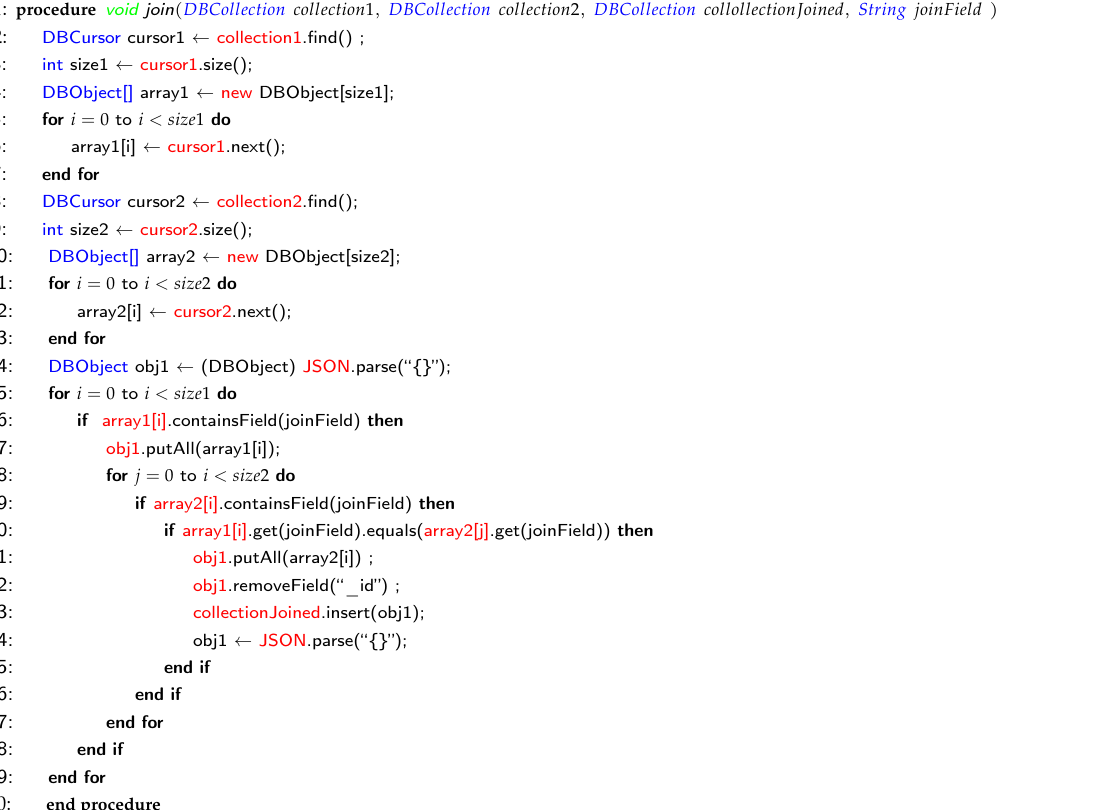
Algorithm 1 Procedure performing an Inner Join operation among two collections in MongoDB.